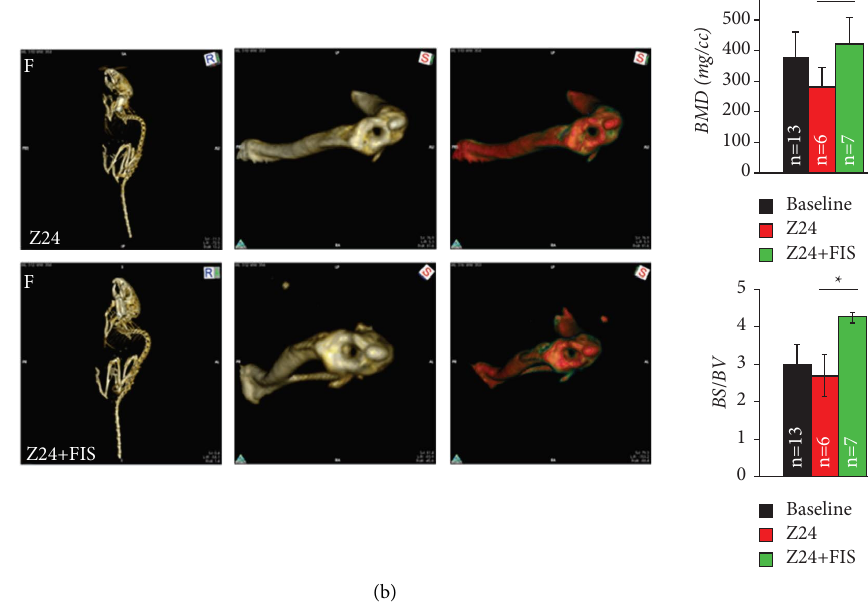
Figure 5: Acute fsetin treatment attenuates bone loss in Z24 mice. (a) Micro-CT images of whole skeleton for 4mo Z24 − / − mice with and without fsetin (FIS) versus age-matched WT. (b) Micro-CT-generated bone morphometry of tibiofemoral joint (knee) of Z24 mice with or without 1-month fsetin treatment. Quantifcation of micro-CT imaging for Hounsfeld unit (HU) intensity, bone mineral density (BMD), and specifc bone surface (BS/BV). Quantifcation based on nontreated Z24 − / − control mice ( n � 7, ∗ P ≤ 0 .